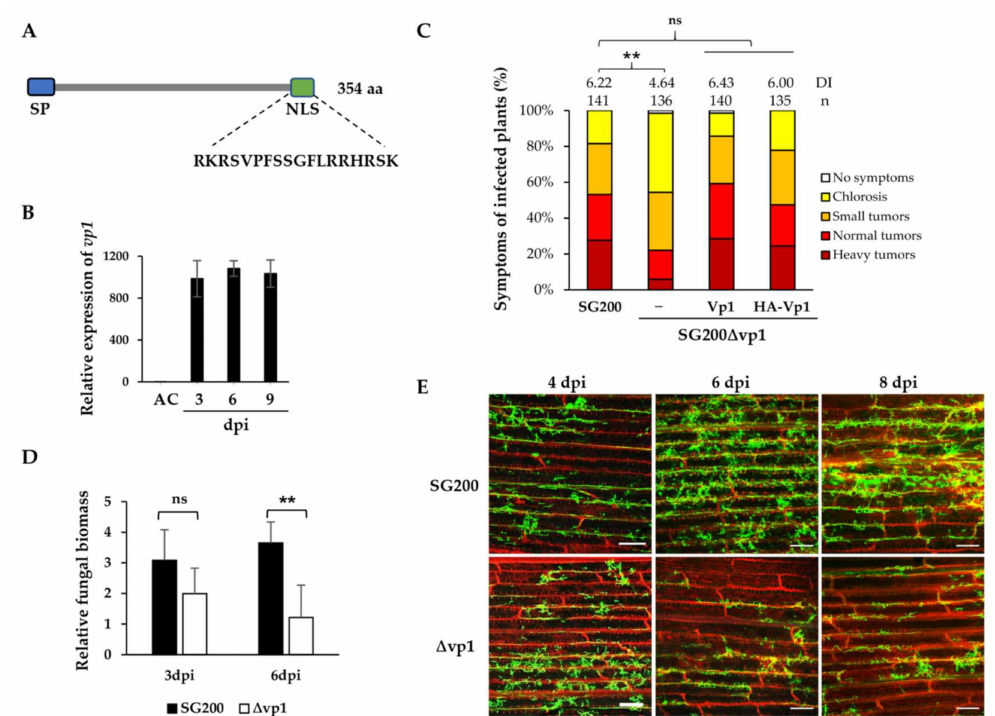
Figure 1. UmVp1 is an important virulence factor of U. maydis. ( A ) Schematic drawing of Vp1 with a predicted N-terminal signal peptide (SP) and C-terminal nuclear localization signal (NLS). The predicted NLS sequence is shown. ( B ) Gene expression profiling of vp1 by qRT-PCR. Total RNA was extracted from SG200 infected maize leaves which were collected at 3, 6, and 9 days post-infection (dpi) and from cells grown in axenic culture (AC). The constitutively expressed U. maydis peptidylprolyl isomerase ( ppi ) gene was used for normalization. The data represent the mean obtained from three independent experiments and the error bars depict ± SD. ( C ) The 7-day-old maize seedlings were infected with the indicated complementation strains and disease symptoms were scored at 10 dpi; n: indicates total numbers of infected plants from the three independent infection assays; DI is the average disease index value of three independent infection assays; ** p < 0.01 indicates significant differences of disease symptoms in respective complementation strains compared with SG200 determined by a two-tailed Student’s t -test using the disease index values. ( D ) U. maydis ppi gene and Z. mays gapdh gene were used to calculate relative fungal biomass of the indicated strains in the infected leaves at 3 and 6 dpi. The data represent the mean obtained from three independent infection assays and the error bars depict ± SD; ns indicates “not significant”, ** p < 0.01. ( E ) Maize leaves infected by strains SG200 and SG200 ∆ vp1 were collected at the indicated dpi and were stained with WGA-AF488 (green) and propidium iodide (red) to visualize fungal hyphae and plant cell walls, respectively. Bars: 200 µ